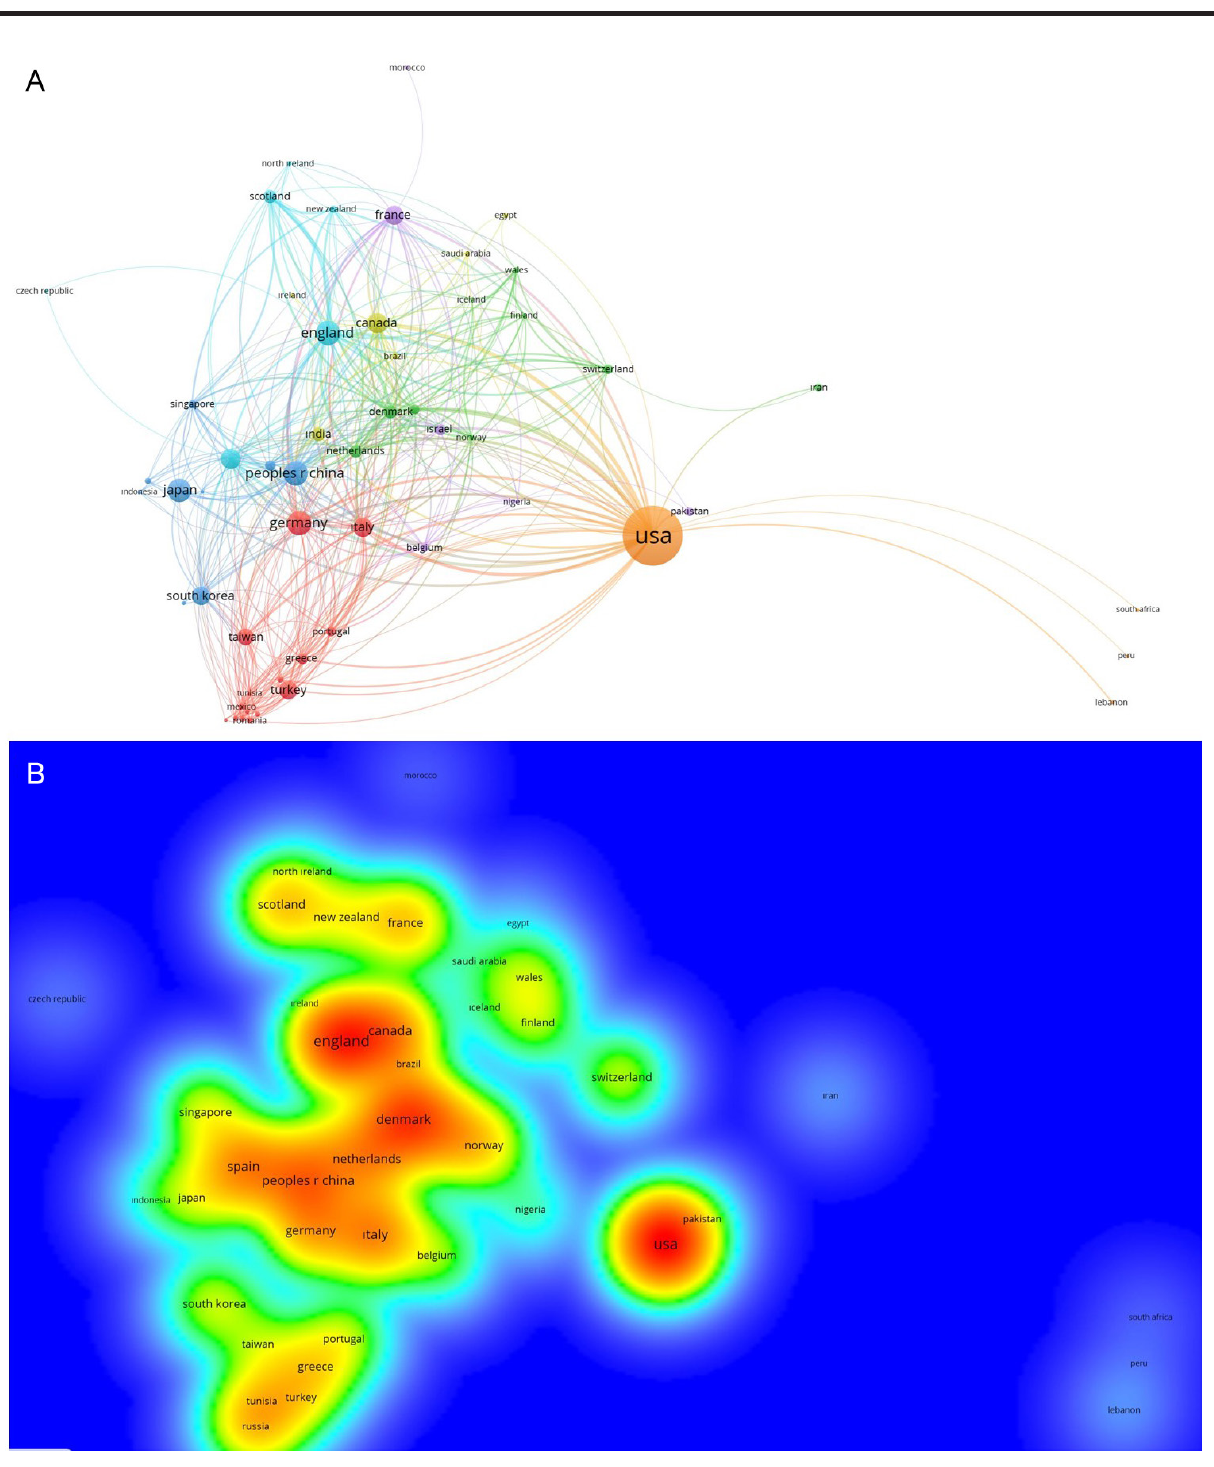
Figure 3 (A) Cluster analysis of international collaboration of worldwide countries on gastrointestinal bleeding. The size of the circle shows a large number of articles. The thickness of the lines indicates the strength of international collaboration. (B) Density map for international collaboration of worldwide countries on gastrointestinal bleeding. International collaboration increases from blue to red (blue -gree n-yel low-r